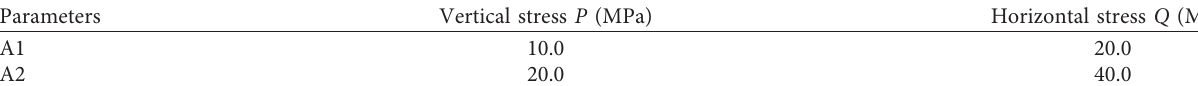
Table 3: Parameters of the calculation model.